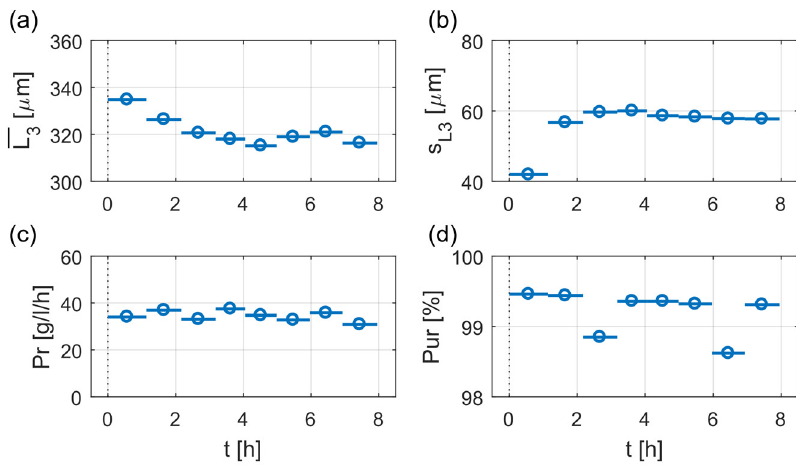
Figure 6. Evolution of mean product crystal size, L 3 ( a ), its respective standard deviation, s L3 ( b ), productivity, Pr ( c ), and product purity, Pur ( d ), of Exp. 7 (C1) over time, with t = 0 indicating the initial seeding point. Illustrated are the values of the process characteristics for every product withdrawal as points with their corresponding time window as line.